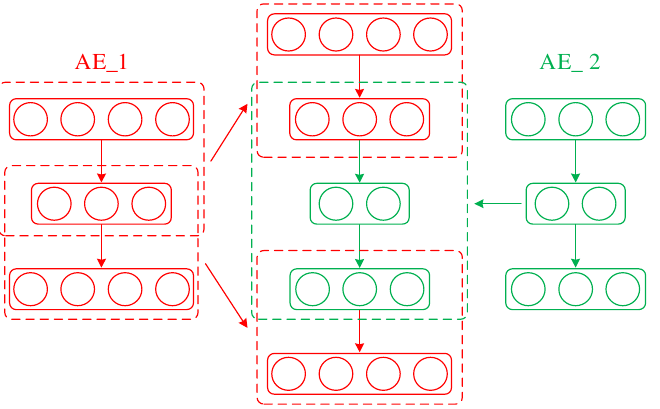
Figure 3. Schematic of the DSAE network. The first AE is in red, and the second AE is in green. Their position in the DSAE can also be